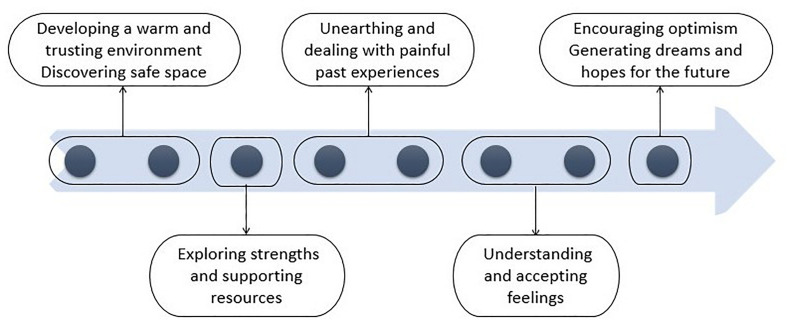
Therapeutic model.